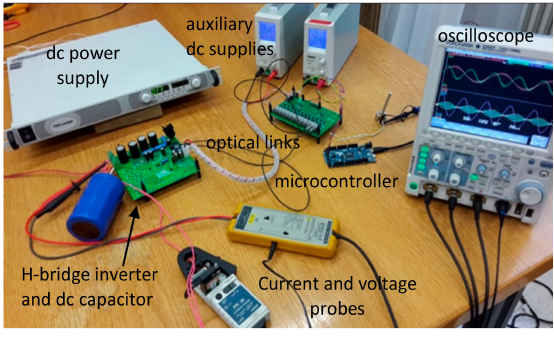
Figure 10. Experimental setup.